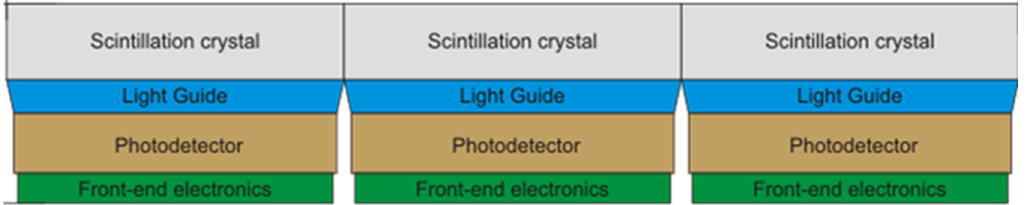
Figure 3. Schematic representation of a cross-sectional view of three tiled block